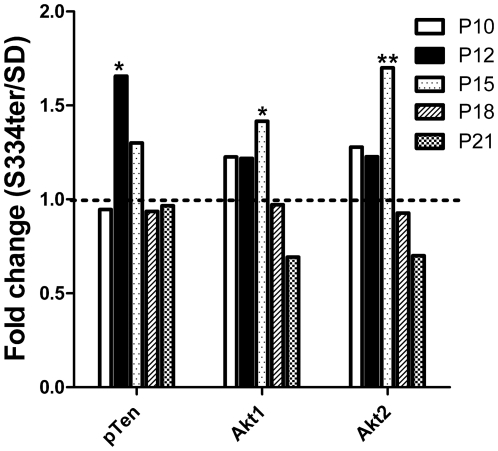
Relative expression of pTten, Akt1 and Akt2 genes in S334ter-4 Rho retinas.Relative gene expression in S334ter-4 Rho retina was measured on P10, P12, P15, P18 and P21 and a fold change was expressed as a ratio of S334ter-4Rho relative expression to SD relative expression. An approximate 1.65-fold increase in the relative expression of the pTen gene was observed (0.80±0.13 vs. 1.5±0.2, P<0.05) in P12 transgenic retinas. Subsequently, the expression of this gene decreased to WT levels. In contrast, the expression of the Akt1 and 2 genes increased after P12 and reached a peak on P15. The Akt1 gene expression was 0.84±0.15 in SD retinas vs. 1.40±0.13 in S334ter-4 Rho retinas, P<0.05. The Akt2 gene expression was 1.03±0.17 in SD vs. 1.70±0.15 in P15 S334ter-4 Rho, P<0.01.